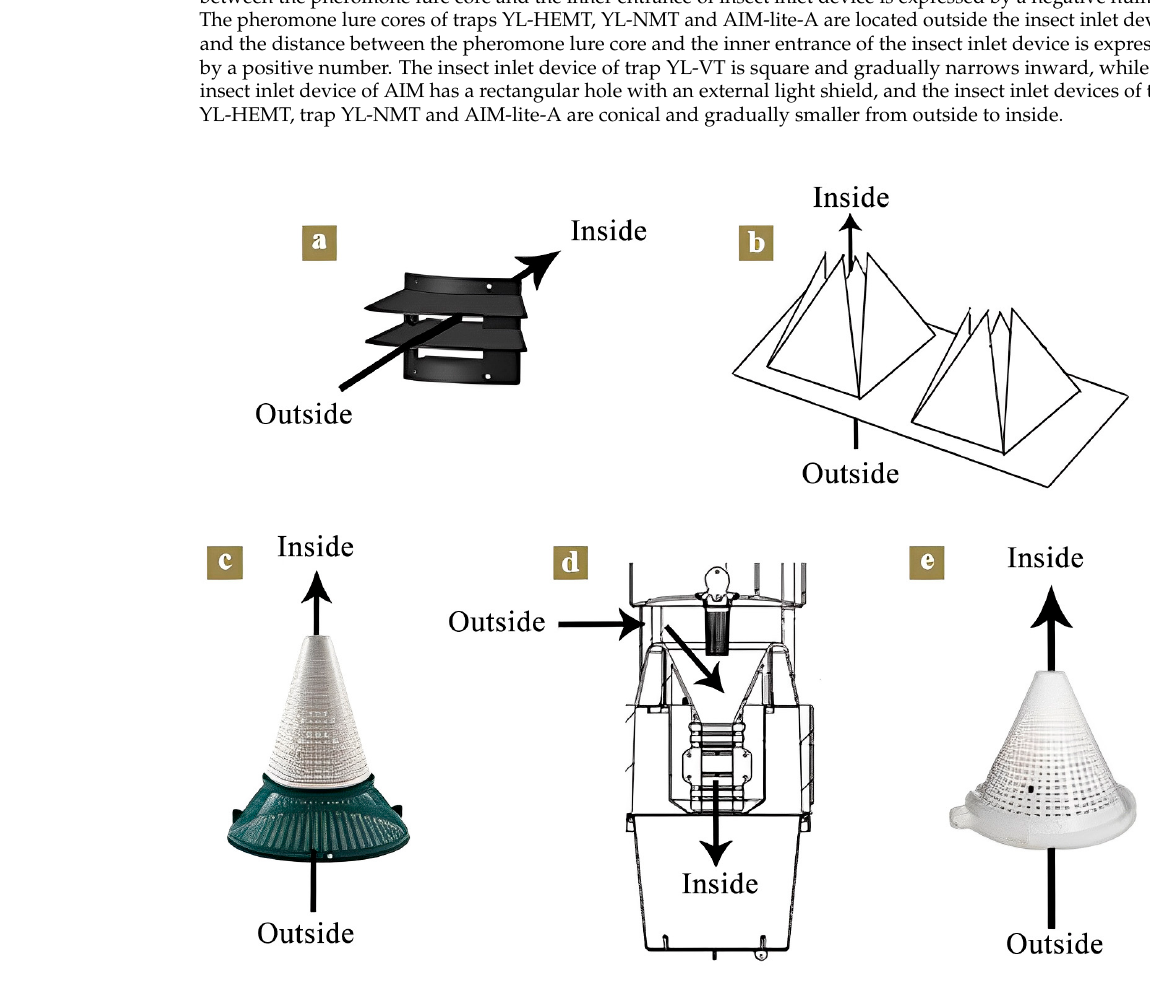
Table 1. Morphological parameters of insect inlet devices of five types of traps.